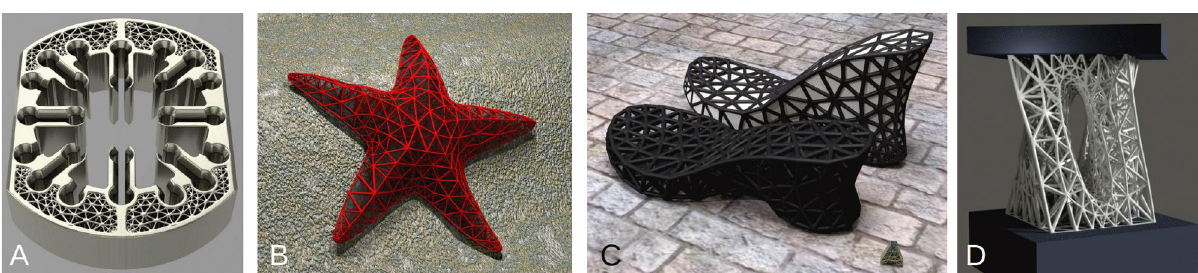
Figure 3. Examples of HGons applied to complex topologies: ( A ) a flow-optimized nuclear fuel rod cassette, ( B ) a ‘starfish’ biomimetic structure, ( C ) footwear Hgons, and ( D ) a multiply-connected HGon under high load- deformation having both sharp linear and smooth curved